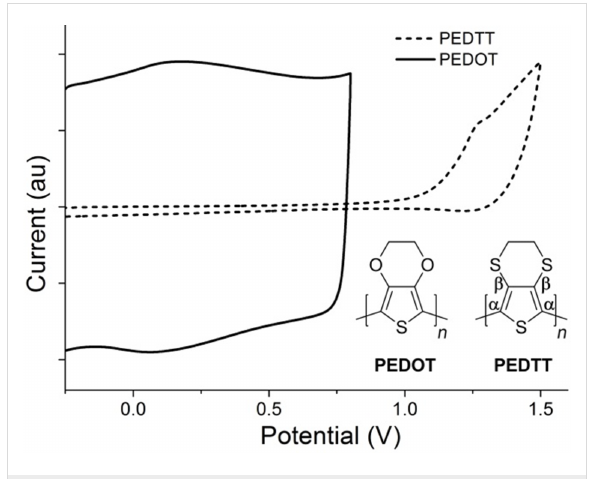
Figure 1: Oxidative wave for PEDOT (black line) and PEDTT (dashed line), together with the corresponding